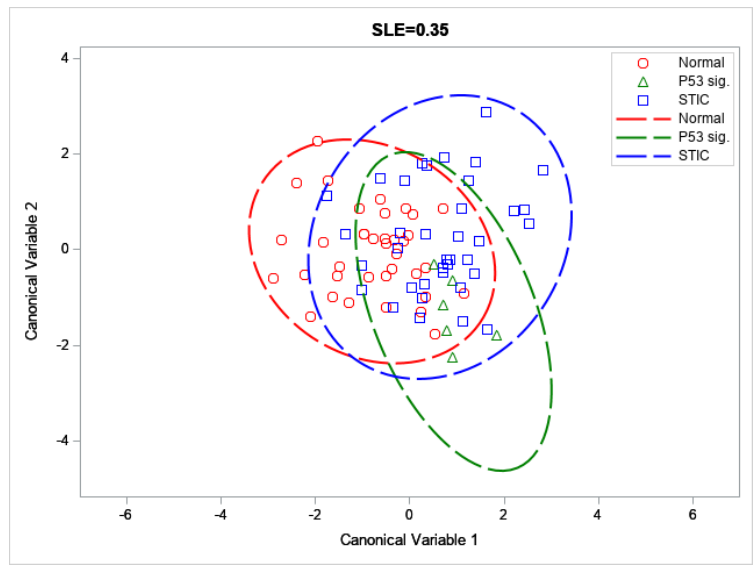
Figure 5. Scatter plot of the distal normal, p53 signature, and STIC across the first two canonical variables; with 95% confidence ellipses depicted by dashed lines.